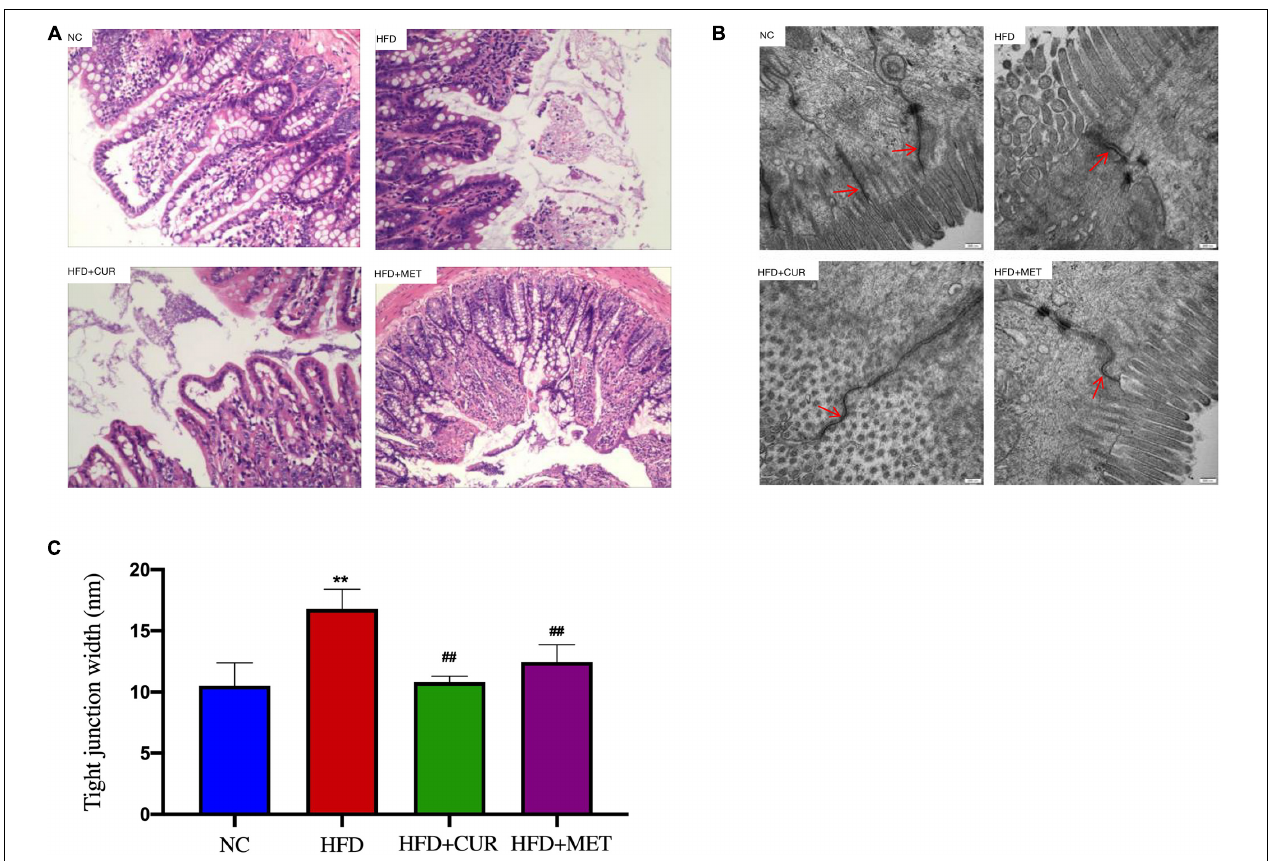
FIGURE 5 | Influence of CUR and MET administration on intestine. (A) HE-stained Ileal tissue. (B) Ultrastructural observation of the tight junctions in the ileal mucosa (transmission electron microscopy, 50,000 × ). (C) Width of the tight junction gap. Seven rats per group ( n = 7). Values are presented as the means ± SD for each